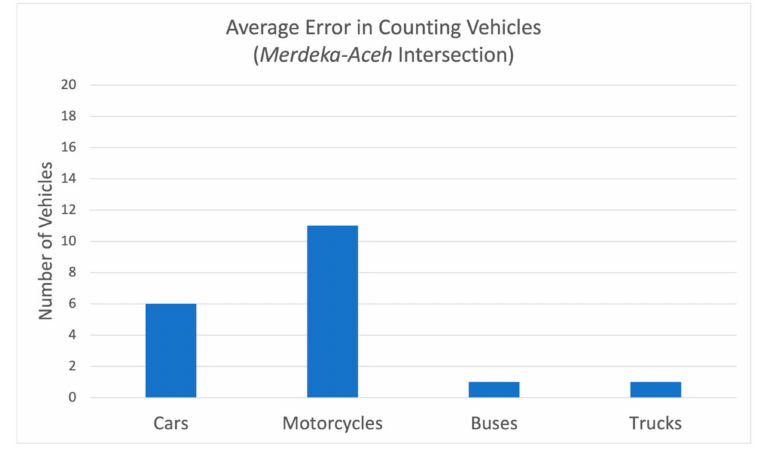
Figure 18. Average error value for vehicle counting on Merdeka-Aceh.